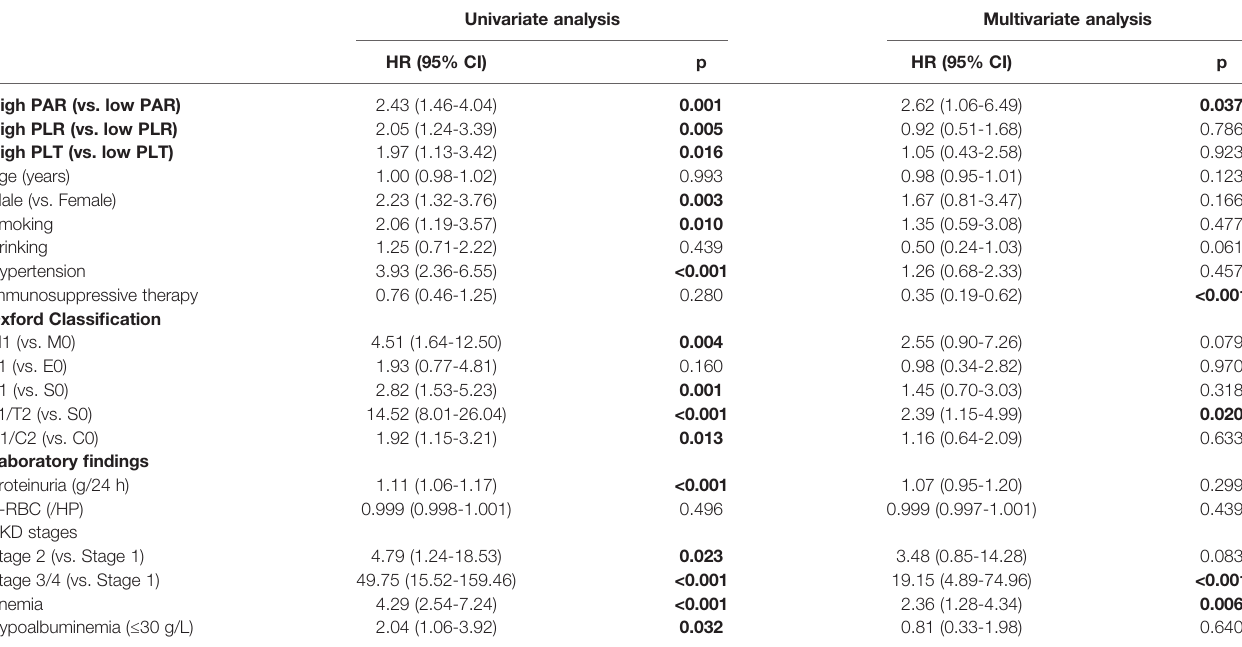
TABLE 2 | Prediction of renal outcomes in the IgAN carried out by Cox-regression analysis adjusted for PAR, PLR, clinicopathologic fi ndings and demographic data. Univariate